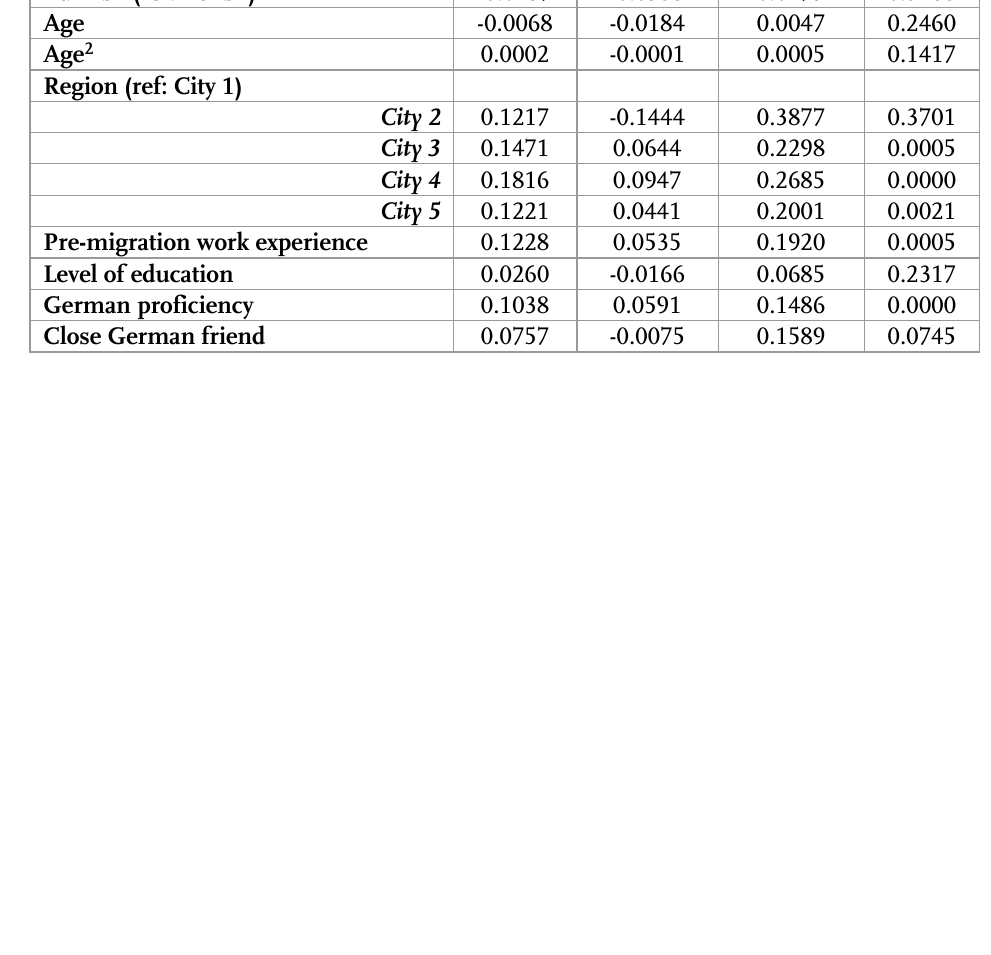
Resources model (DV: Labour force participation) AME CI lower CI upper